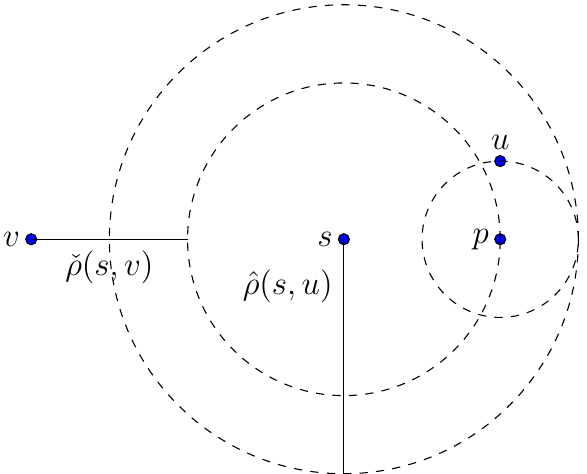
Figure 2. Unsuitable condition for the δ -criterion. The success of the δ -criterion basically depends on the distance between query vertex s and pivot p . Here, although u is closer to s than v , the δ -criteria is in this situation